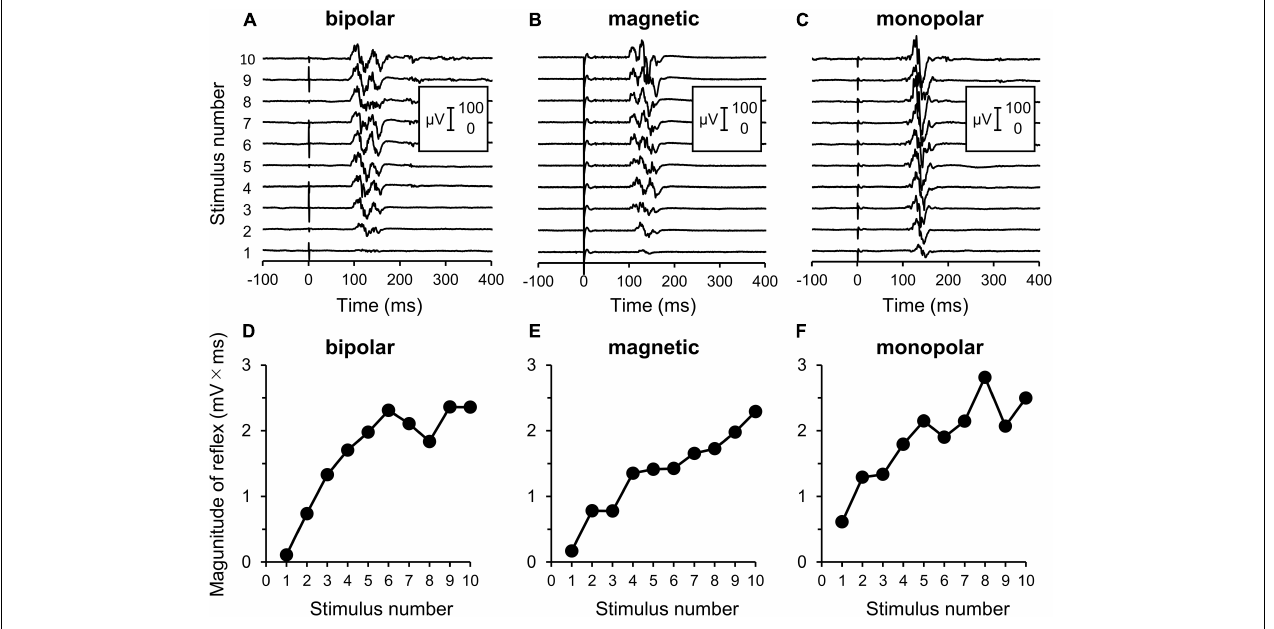
FIGURE 2 | Electromyography (EMG) recordings of flexion reflex and procedures of analyses. (A–C) Original waveforms of a representative subject elicited by a series of 10 consecutive stimuli at the reflex threshold at 2 Hz by bipolar, magnetic, and monopolar stimulations in Experiment 3. (D–F) Relationship between the reflex magnitude [area under the curve (AUC)] and stimulus number. Note that the reflex is clearly enhanced with repeated stimulations.